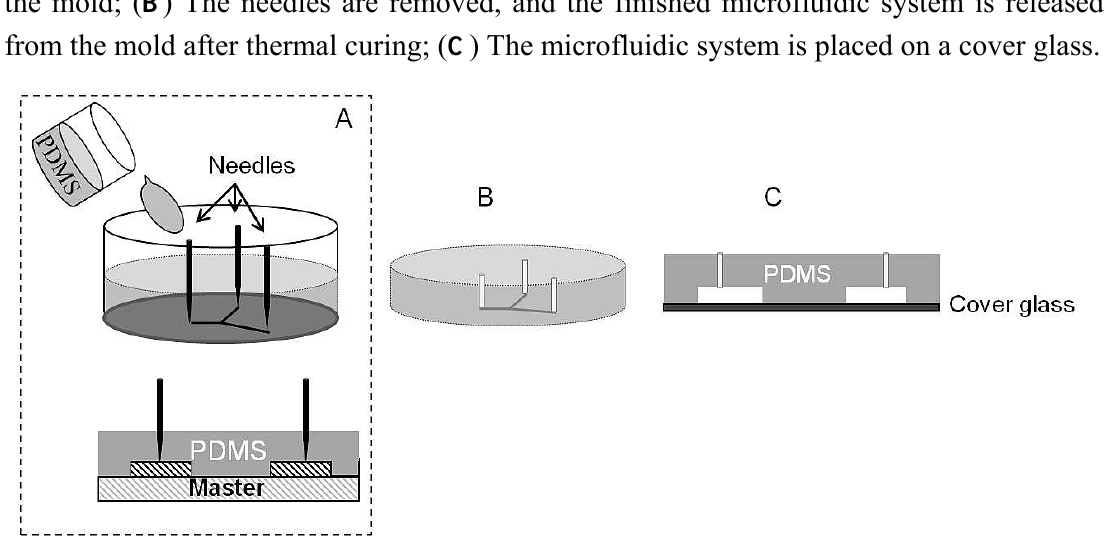
Figure 4. Replication of PDMS based microfluidic devices produced by soft